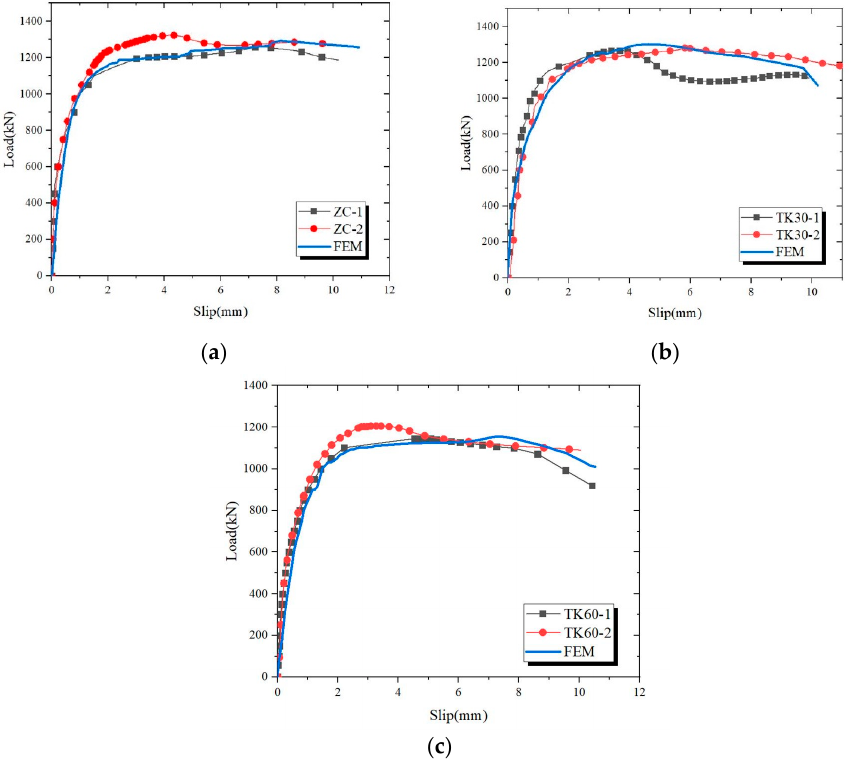
Figure 21. Comparison of load-slip curves from tests and FE analysis: ( a ) ZC group; ( b ) TK30